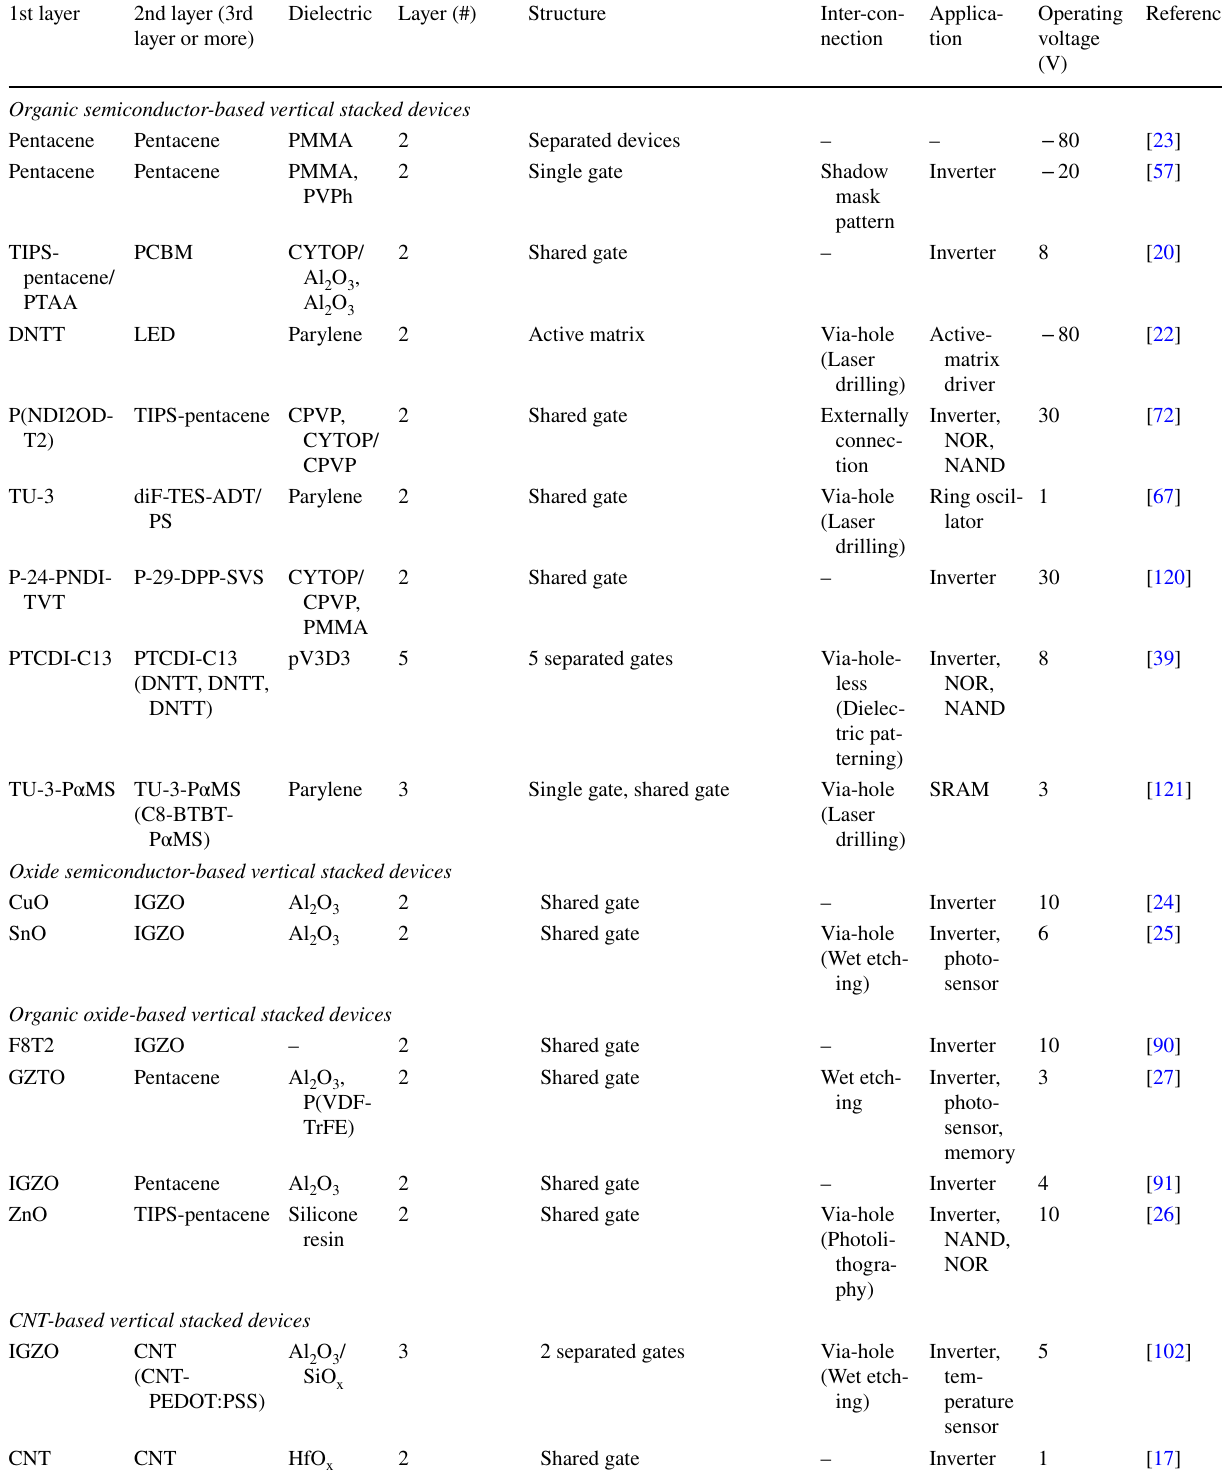
Table 1 Summary of previously reported emerging material-based vertical stacking applications 1st